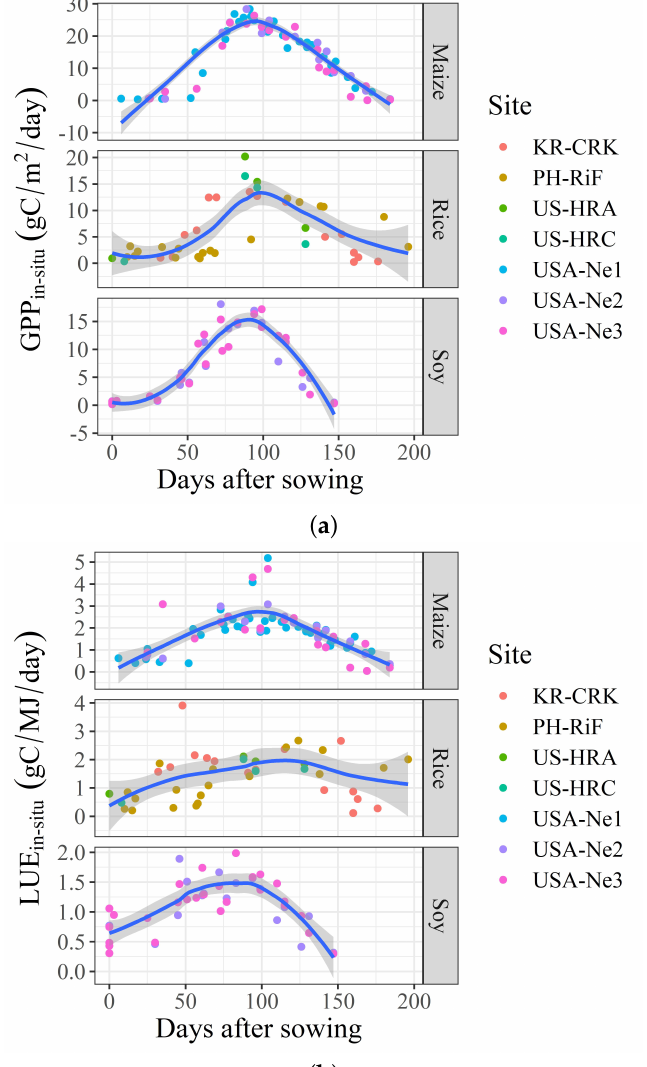
Figure 3. Figures showing ( a ) in situ Gross Primary Productivity (GPP) and ( b ) light use efficiency (LUE) aggregated by crop type and over crop seasons by day after sowing. Colours denote codes for the FLUXNET flux tower sites shown in Table 1. Plotted lines were fitted with a local polynomial regression and ribbons show the 95% confidence